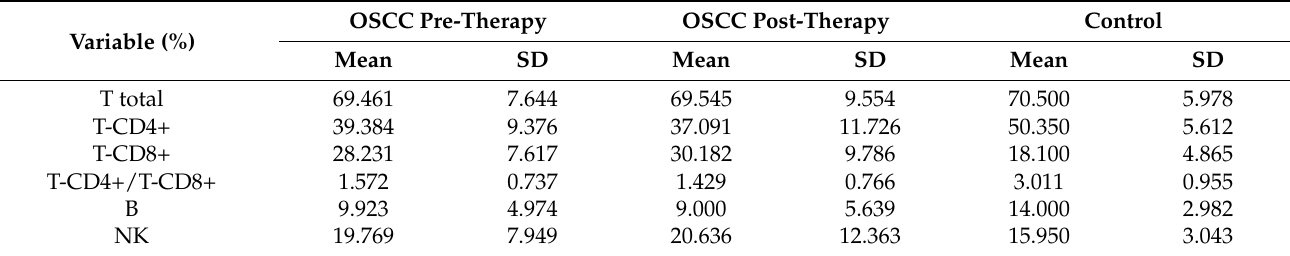
Table 3. Proportion of lymphocyte subtypes in the three study